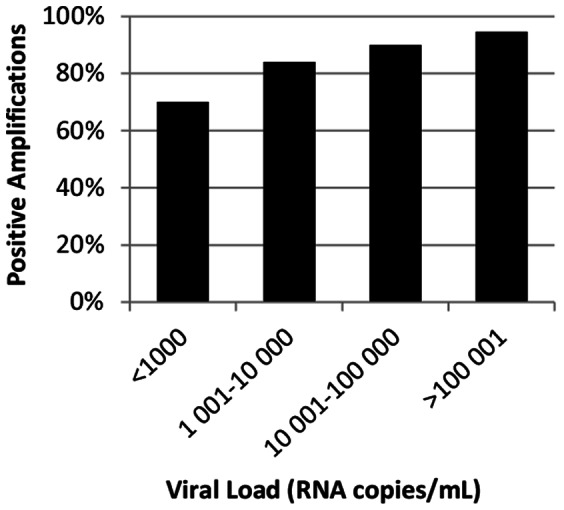
Distribution of PCR amplification success stratified by viral load.The Env ectodomain was amplified from plasma viral RNA by a one-step RT-PCR followed by an inner PCR. Five independent PCR amplifications were pooled to minimize primer-related selection. 292 samples from patients infected with HIV subtypes A1, B, C, D, F, G, CRF01_AE and CRF02_AG were included. Viral load ranged from 466 to 1,350,000 RNA copies/mL.